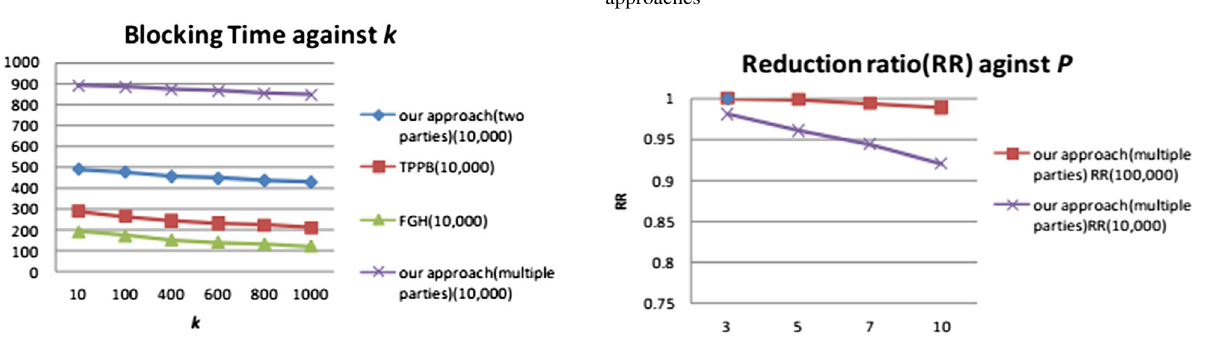
Fig. 8 Blocking time with different values for k , dataset size = 10,000